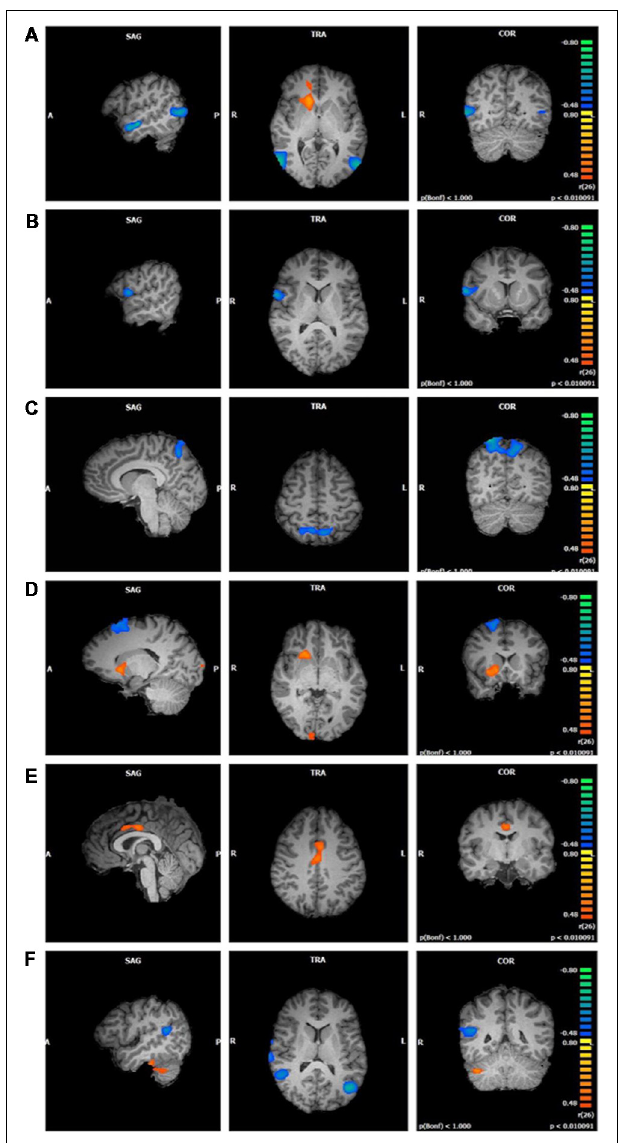
FIGURE 1 | Functional connectivity of default mode network (DMN) clusters correlated with trait mindfulness and five of its facets ( p < 0.01, cluster threshold estimator corrected). From top to bottom: (A) FFMQ Total ; (B) Observing ; (C) Describing ; (D) Acting ; (E) Non-Judging ; (F) Non-Reactivity